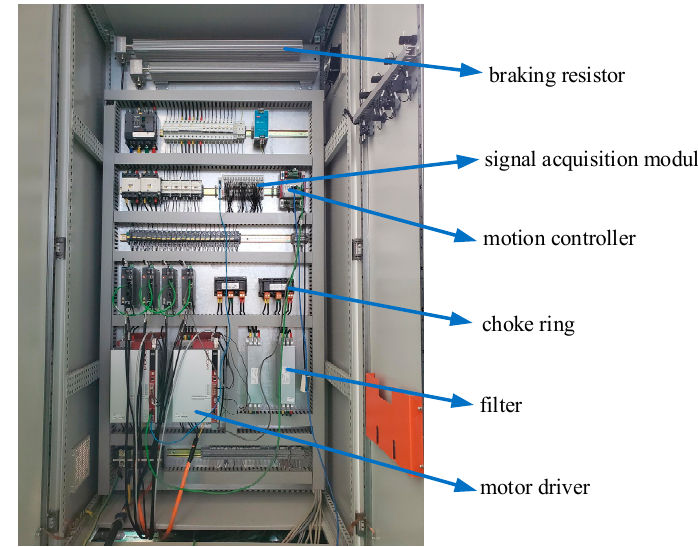
Figure 10. EHA electrical control system.